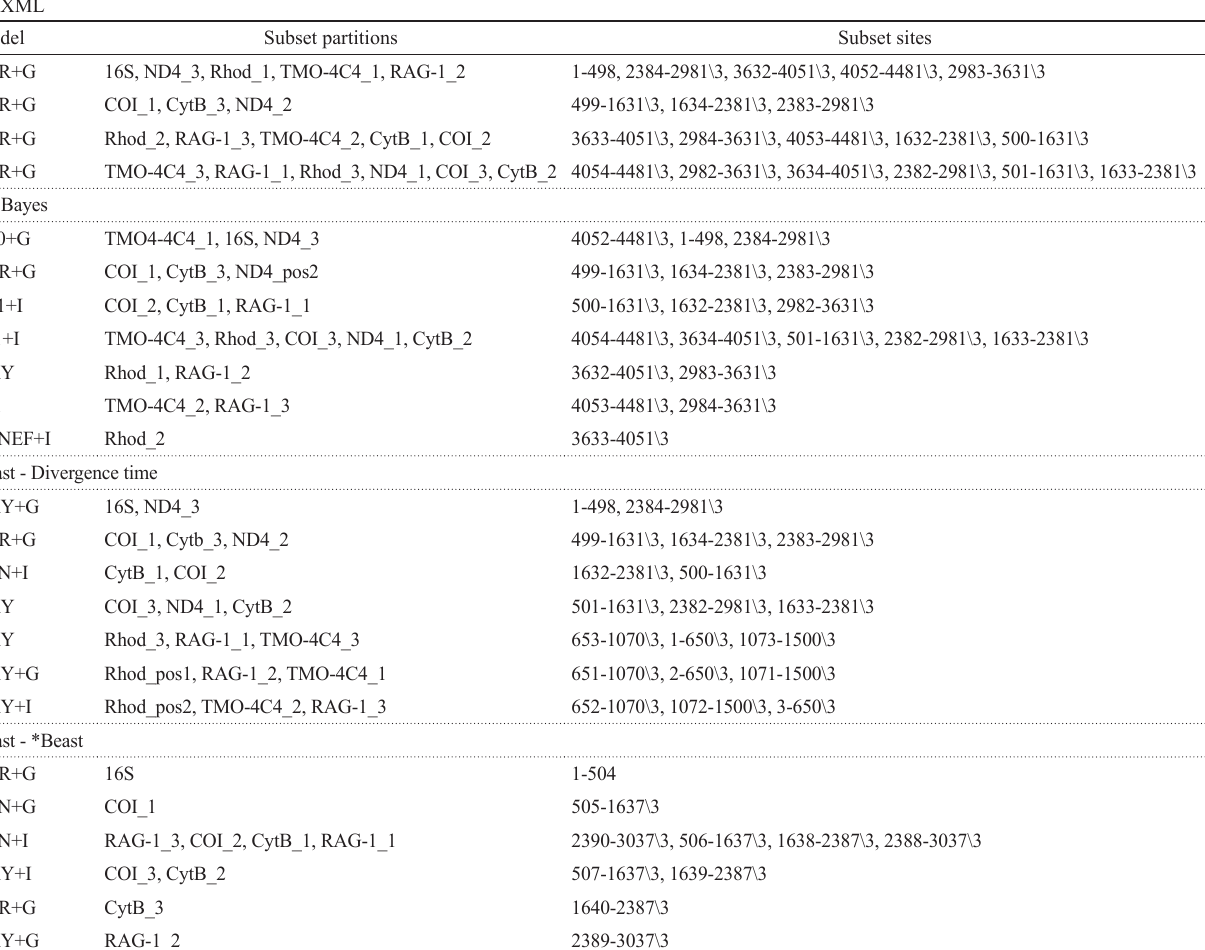
Tab. 3. Nucleotide substituition models selected by PartitionFinder for each gene partition, and their position in the alignment, for each phylogenetic analysis performed in the present